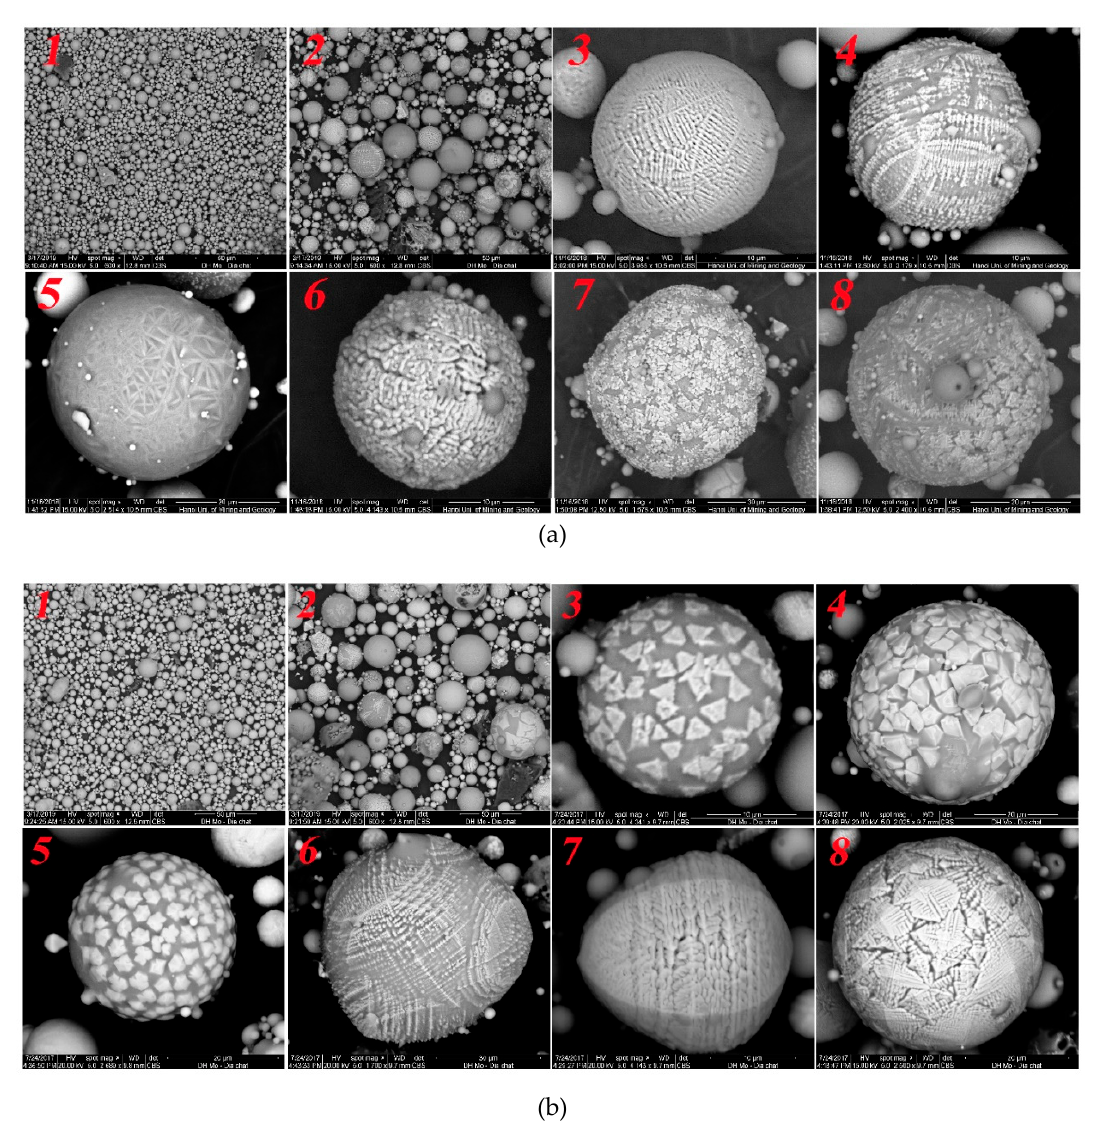
Figure 4. ( a ) Morphotypes of nonmagnetic ( 1 ) and magnetic particles ( 2 – 8 ) of Uong Bi (UB) fly ash; ( b ) Morphotypes of nonmagnetic ( 1 ) and magnetic particles ( 2 – 8 ) of Pha Lai (PL) fly ash.